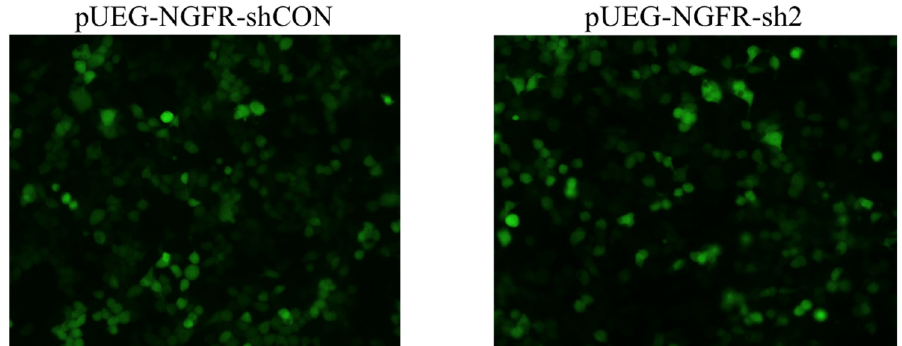
Figure 1. GFP expressed by the transfected cells. The 293T cells were co-transfected with shRNA plasmid and pCAGIG- Ngfr -cDNA.